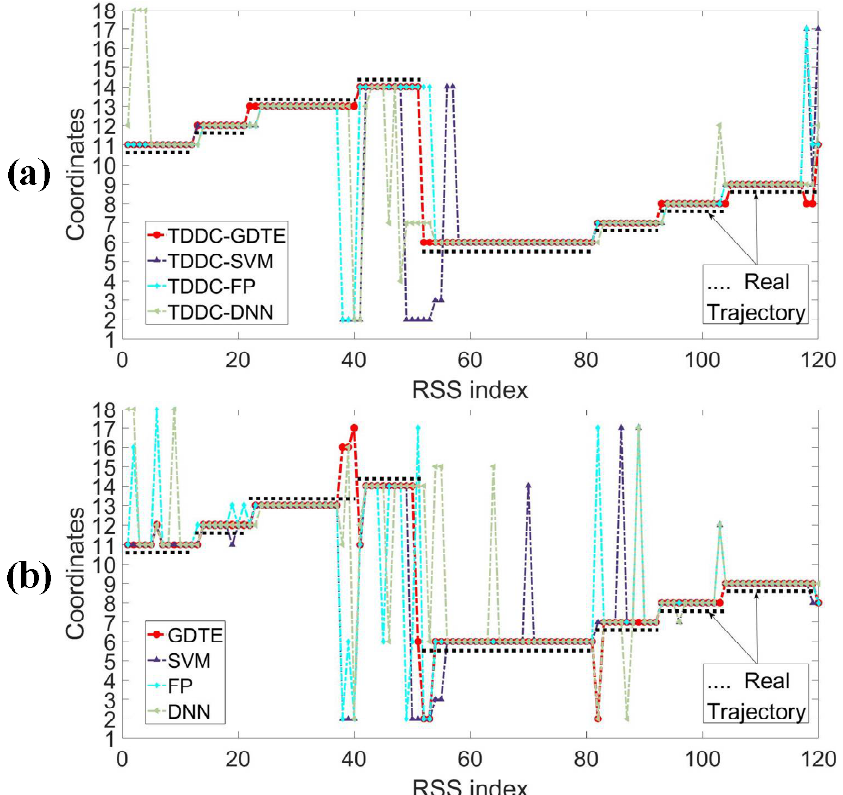
Figure 11. The classification results of a testing sample processed by the different localization models with and without the TDDC wavelet filter. ( a ) The testing sample was filtered by the TDDC wavelet filter. ( b ) The testing sample was not